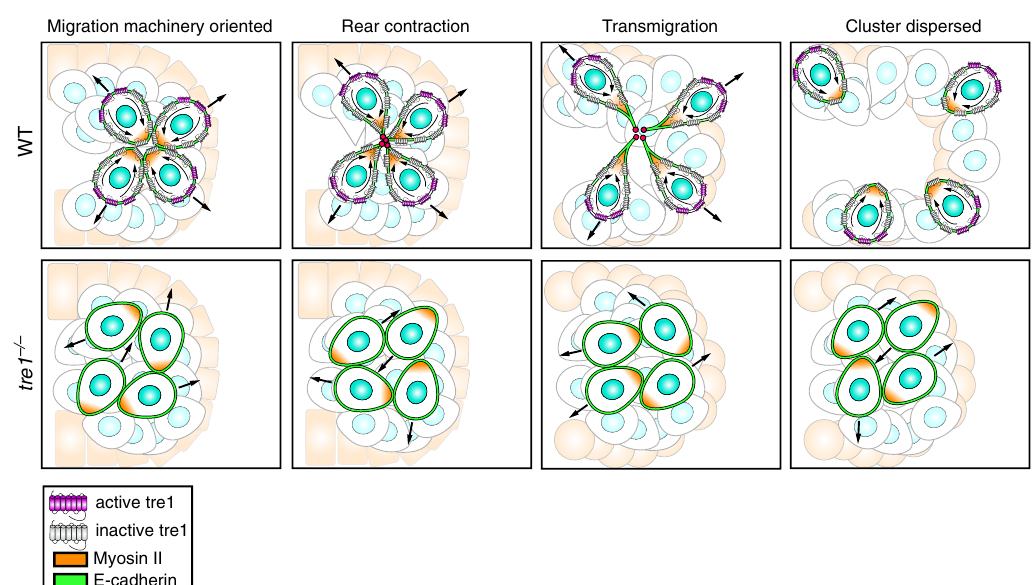
Fig. 8 PGC clusters disperse by directing individual migratory polarity outward to collectively remove cell – cell adhesions. PGC clusters disperse by utilizing Tre1 − / − to interpret a presumed migratory cue presented at the exterior of the cluster to orient and stabilize individual migratory polarity radially from the cluster. Sustained polarization of myosin II contracts posterior cortices into foci as PGCs separate. Across the cluster, the opposing directions of PGC migration facilitate a collective response by aligning diametric migratory forces, akin to breaking a rope (cell adhesions) by pulling both ends apart. E- cadherin remains present on the cell membrane throughout. In the absence of Tre1 − / − , PGC motility is randomized, resulting in a signi fi cant decrease in migration persistence. Clusters remain intact as PGCs are unable to orient their migration in a given direction for a suf fi cient time period to